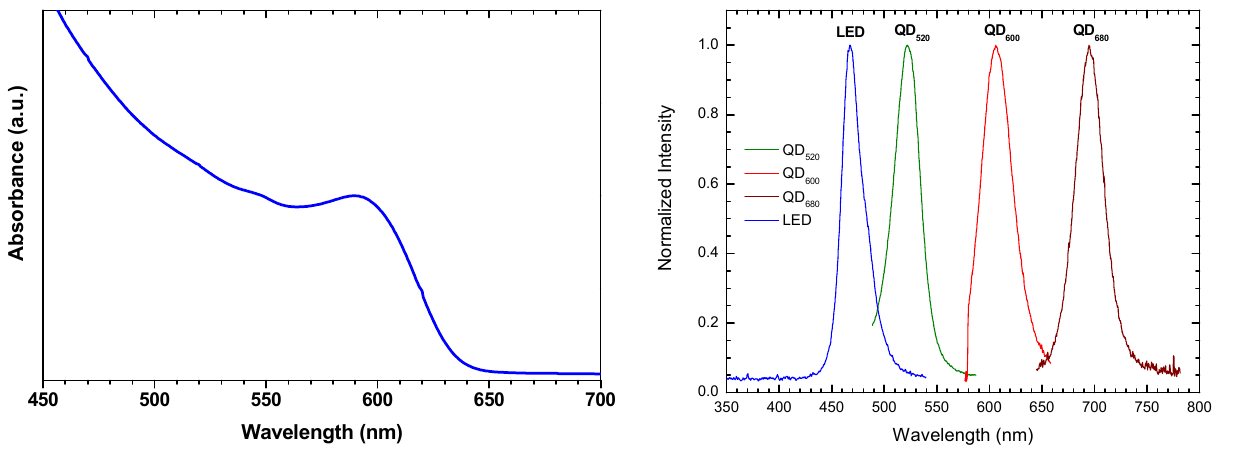
Figure 1. Left –Typical absorption spectrum of CdSe nanocrystal QDs. Right - Normalized emission spectra of different samples of core-shell QDs immobilized in a sol-gel matrix. Peak emissions from blue to red are 520nm (CdSe/ZnS), 610nm (CdSe/ZnS) and 680nm (CdTe/ZnS). The spectrum of the excitation source, a blue LED (470nm), is also